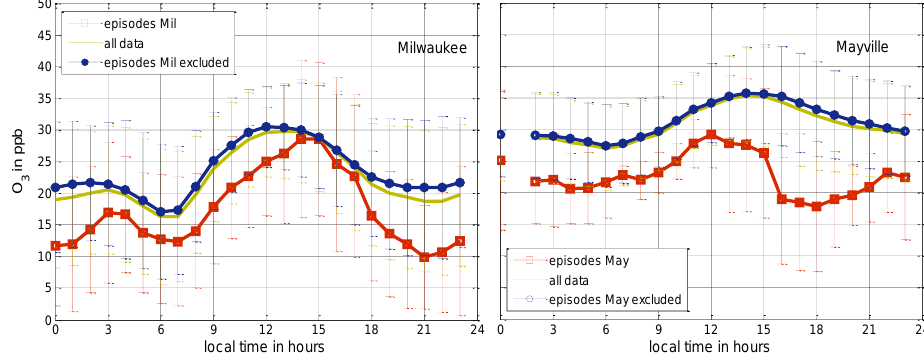
Figure 5. Diurnal pattern for ozone at the urban site (left), and the rural site (left). Error bars represent one standard deviation. 976 Fig. 5. Diurnal pattern for ozone at Milwaukee (left), and Mayville (right). Error bars represent one standard deviation.